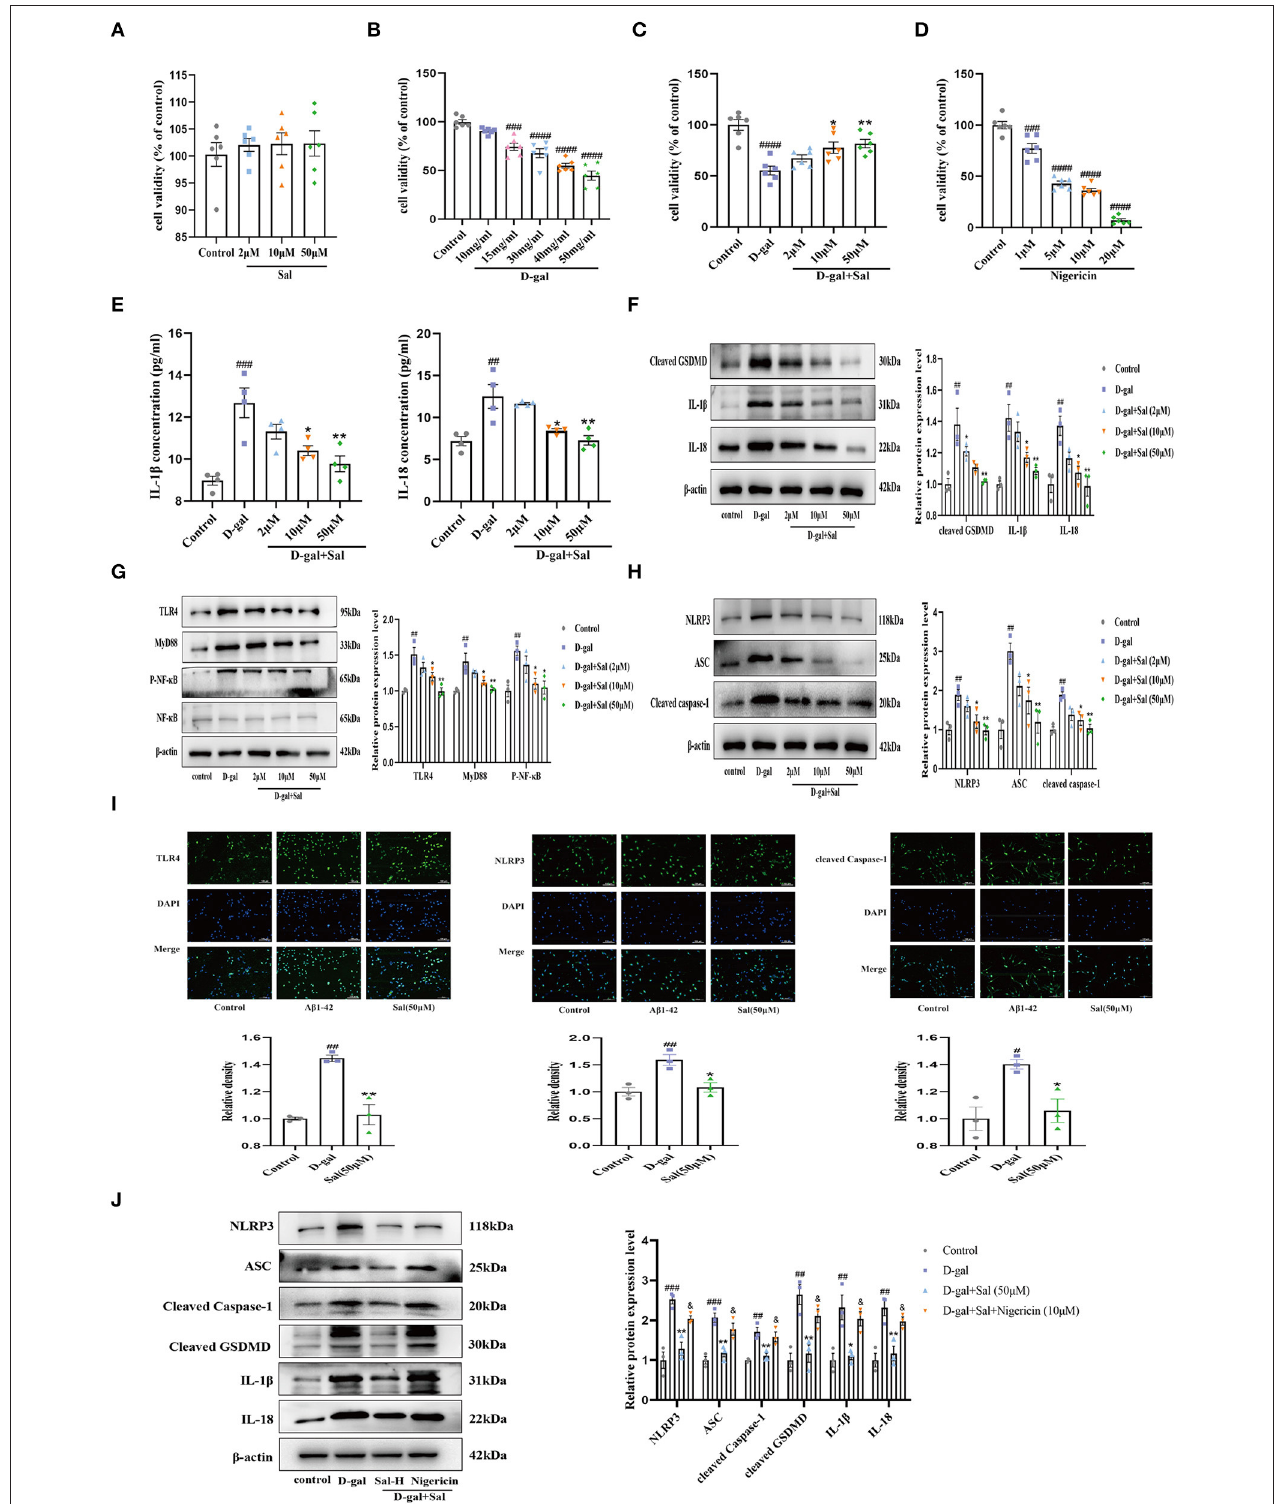
FIGURE 9 | Sal regulated PC-12 cell pyroptosis via inhibiting the TLR4/NF- κ B/NLRP3/ASC/Caspase-1 signaling pathways. (A) CCK-8 measured the cytotoxic effects of Sal on PC12 cells; Sal treatment has no significant cytotoxicity on PC12 cells ( n = 6). (B,C,E) CCK-8 conducted the assays on PC12 cells viability after the